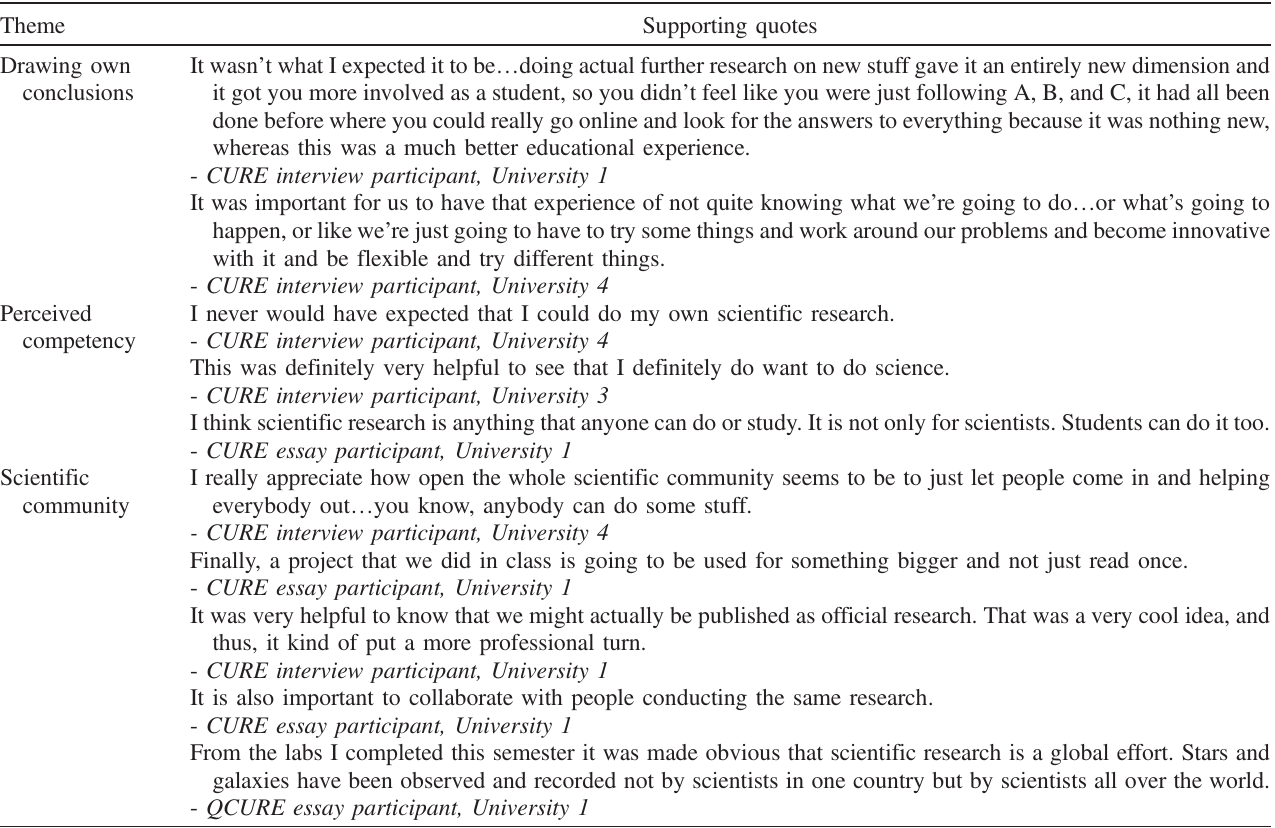
TABLE III. Example quotes expressing three themes related to motivation according to SDT, namely, autonomy, competency, and relatedness,